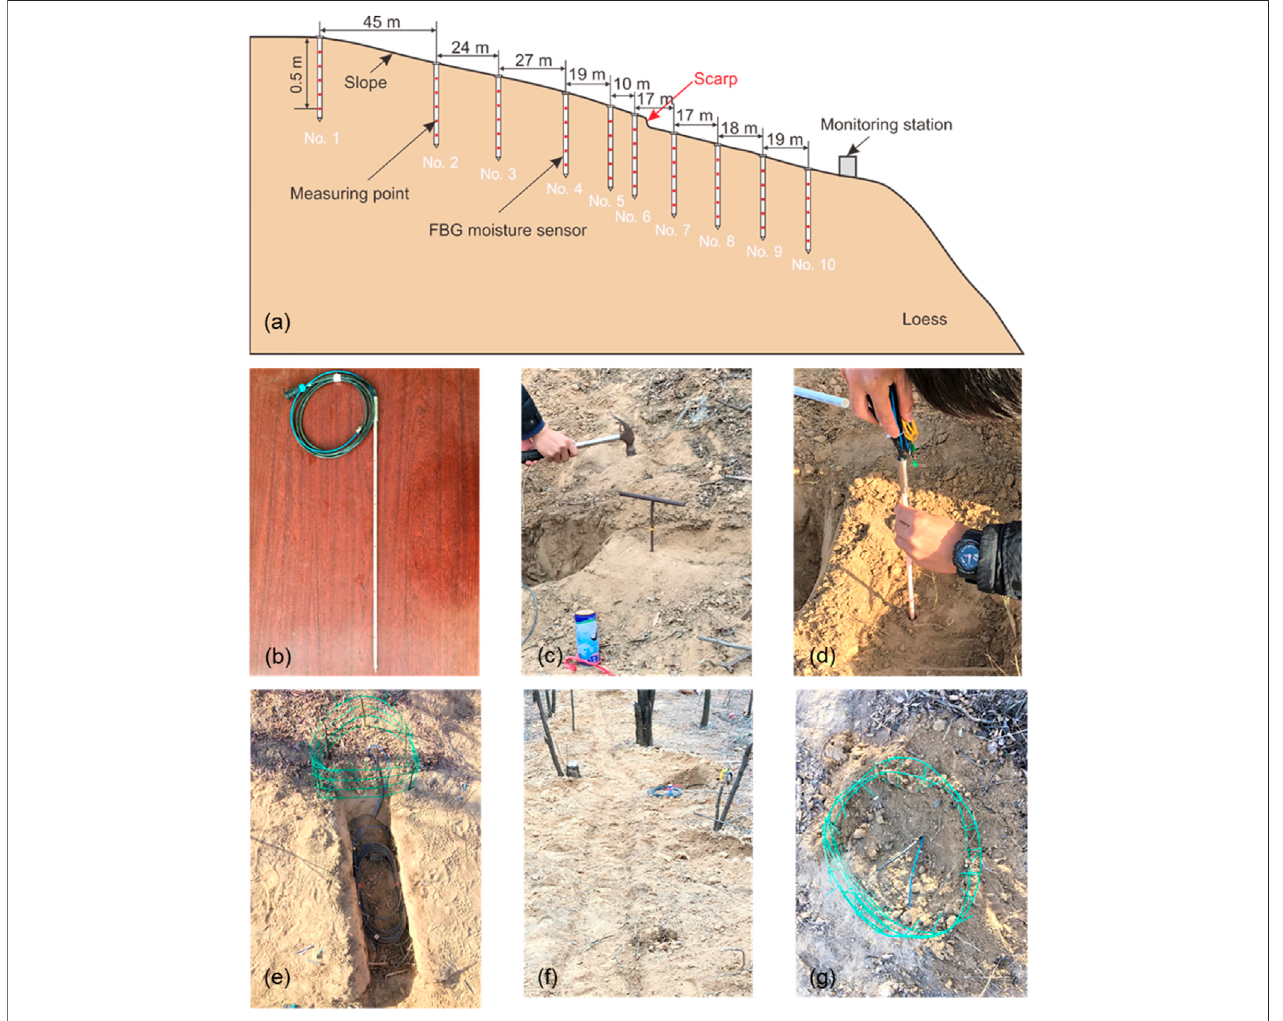
FIGURE 6 | Layout scheme and installation steps of 10 APHSs. (A) Layout scheme. (B) Close-up view of APHS sensor. (C) Boring with a soil extractor. (D) APHS installation. (E) Trench excavation, (F) Trench back fi lling. (G) Fence protection (Sun et al., 2021).